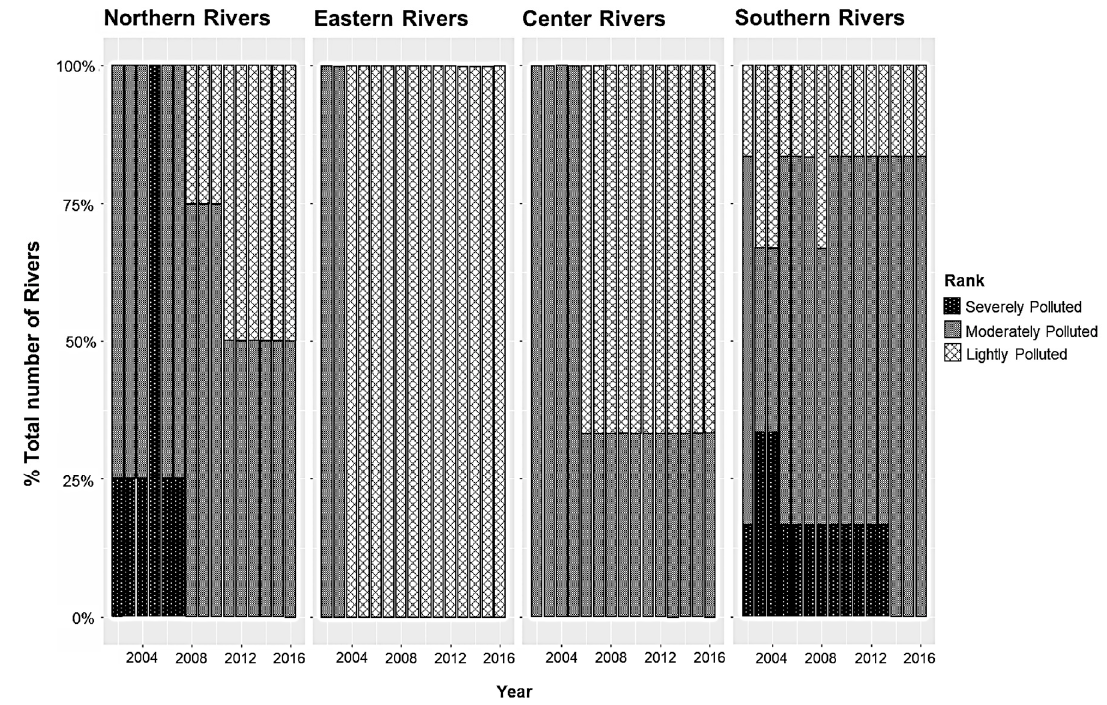
Figure 3. Long-term of RPI rank in 14 Taiwan representative rivers.